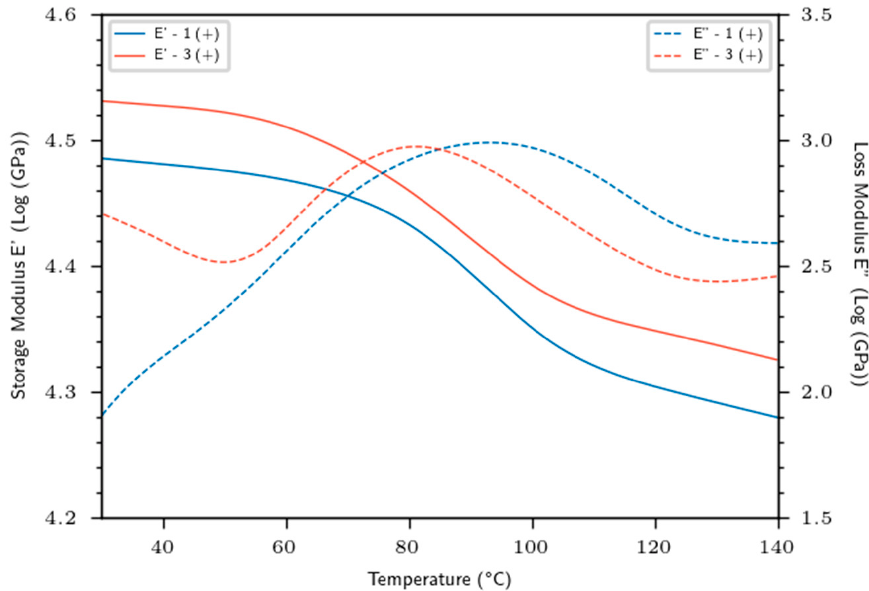
Figure 6. Dynamic mechanical properties of flax biobased materials .